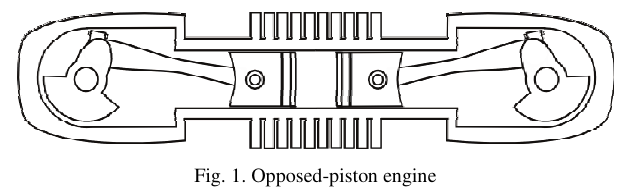
Fig. 1. Opposed-piston